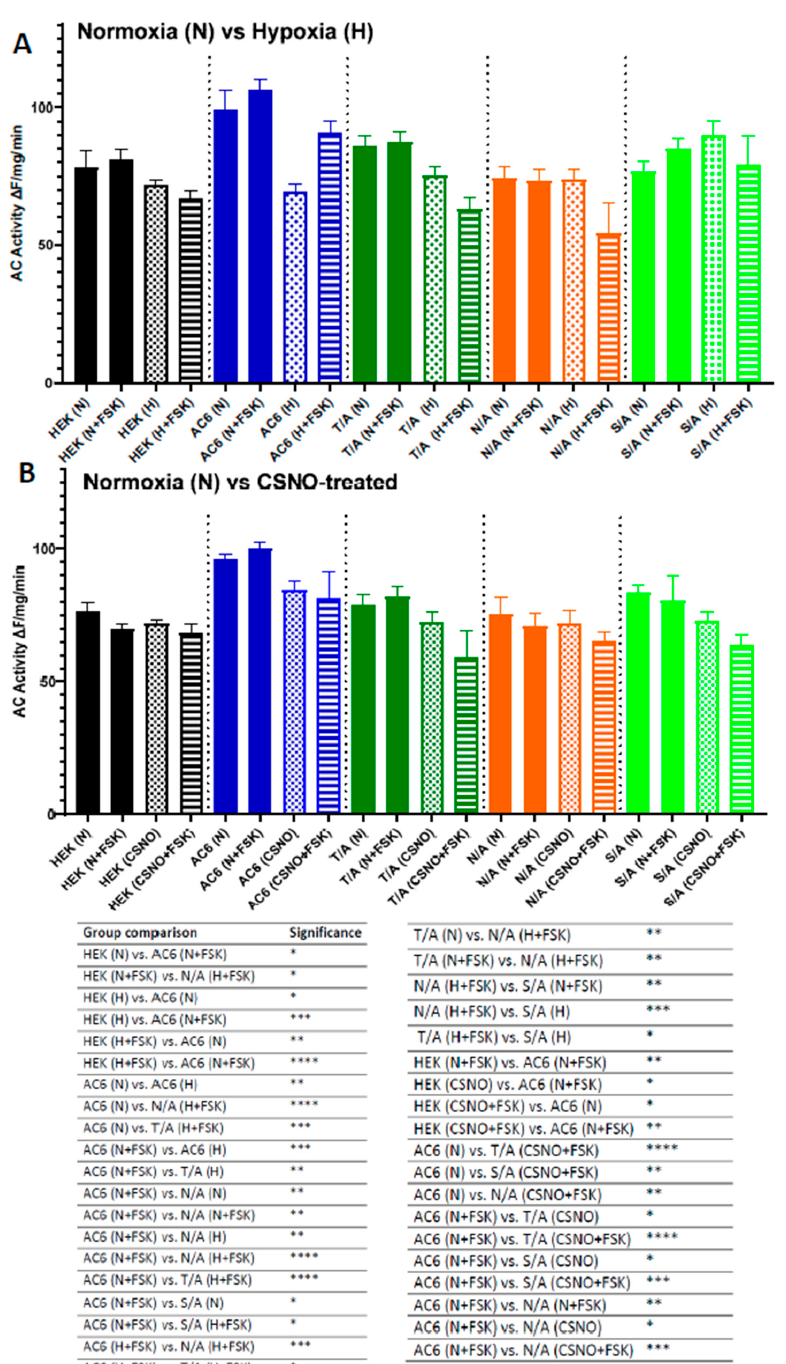
Figure 7. Effect of FSK site mutation on AC activity in normoxia, hypoxia, or after CSNO treatment. AC activity was measured in the total cell lysate of naïve HEK293T cells, HEK293T transfected with AC6 WT, or mutants of Forskolin interacting residues (T500A, N503A, or S1035A) in the presence of 1 mM ATP, with or without 1 µ M Forskolin, following ( A ) 72 h exposure to in vitro hypoxia (H, 10% O 2 , 5% CO 2 ) versus normoxic controls (N 21% O 2 , 5% CO 2 ), or ( B ) 30 min treatment with 250 µ M nitrosocysteine (CSNO) versus untreated controls. N = 3, One-way ANOVA with post hoc Tukey (all individual comparisons shown); * p < 0.05, ** p < 0.01; *** p < 0.001; **** p <